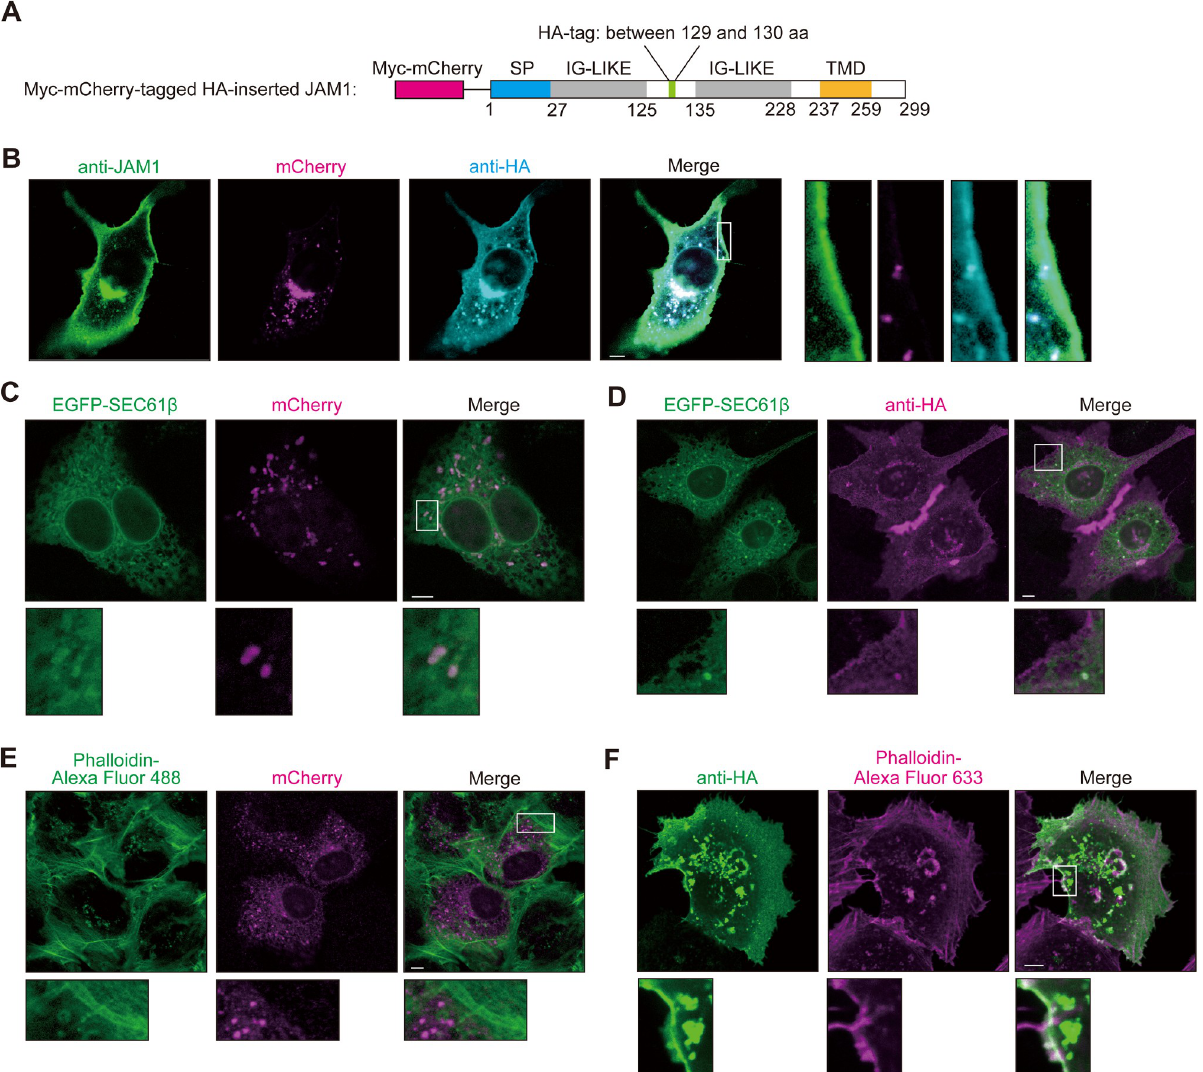
Fig 3. Confocal microscopic images of JAM1 in IHGE cells. (A) Schematic view of the JAM1 construct. The Myc-mCherry tag is indicated by the magenta box, and the HA-tag is indicated by the green box. The signal peptide is indicated by the blue box, and IG-LIKE and TMD domains are indicated by the gray boxes and orange box, respectively. (B) Confocal microscopic images of an IHGE cell expressing Myc-mCherry-JAM1, stained with anti-JAM1 (green) and anti-HA (cyan). mCherry is shown in magenta. Higher magnifications of the areas indicated by the white boxes in the left panels are shown at right. Scale bar, 5 μ m. (C – F) IHGE cells were transiently transfected with plasmids encoding Myc-mCherry–tagged HA-inserted JAM1; in (C) and (D), the cells were also transfected with EGFP-SEC61 β (green). Following 48 h of incubation, cells were fixed, stained with anti-HA (D, magenta; F, green), and also stained with Alexa Fluor 488–conjugated phalloidin (E, green) or Alexa Fluor 633–conjugated phalloidin (F, magenta). The cells were then analyzed by immunofluorescence microscopy. Higher magnifications of the areas indicated by white boxes in the upper panels are shown on the lower side. Scale bars, 5 μ m. See also S9A–S9D Fig.